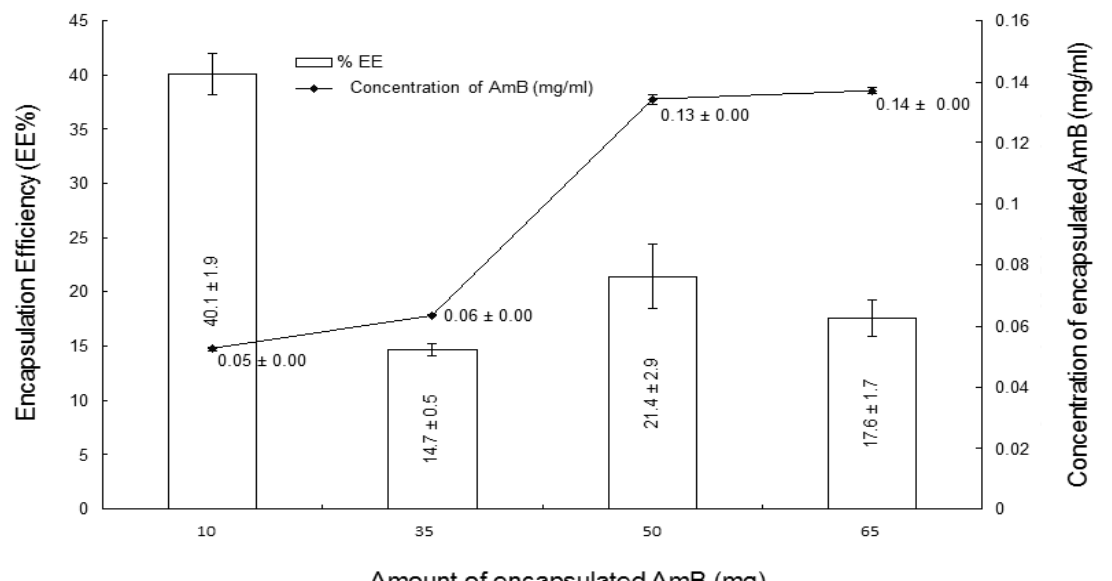
Figure 1. Concentrations and encapsulation efficiencies of AmB within the solid lipid nanoparticles ( n =